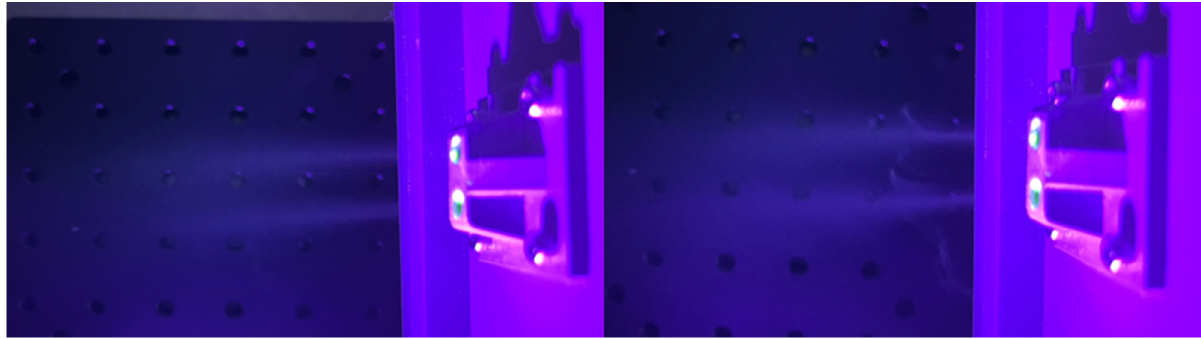
Figure 11. Odor flows through an artificial nose structure.